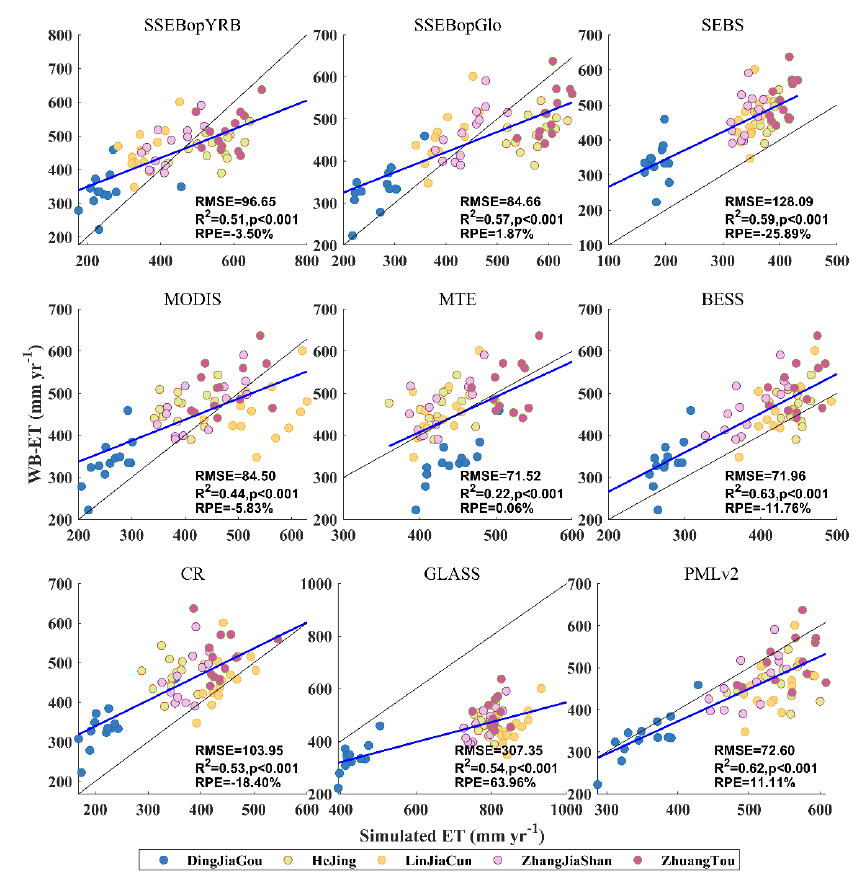
Figure A11. Annual ET derived from MOD11A1 and MYD11A1 over the whole YRB during the years 2003–2015. Remote Sens. 2020 , 12 , x FOR PEER REVIEW